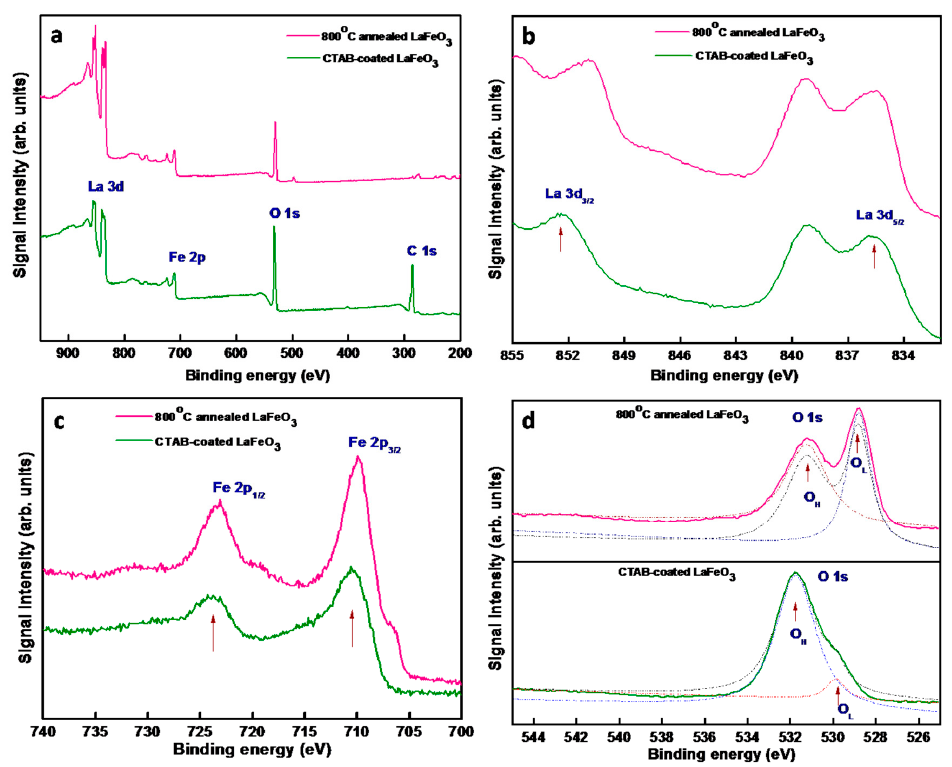
Figure 3. ( a ) X-ray photoelectron spectroscopy (XPS) full spectra; ( b ) La 3d; ( c ) Fe 2p; and ( d ) O 1s spectra of CTAB-coated and 800°C annealed LaFeO 3 nanoparticles.